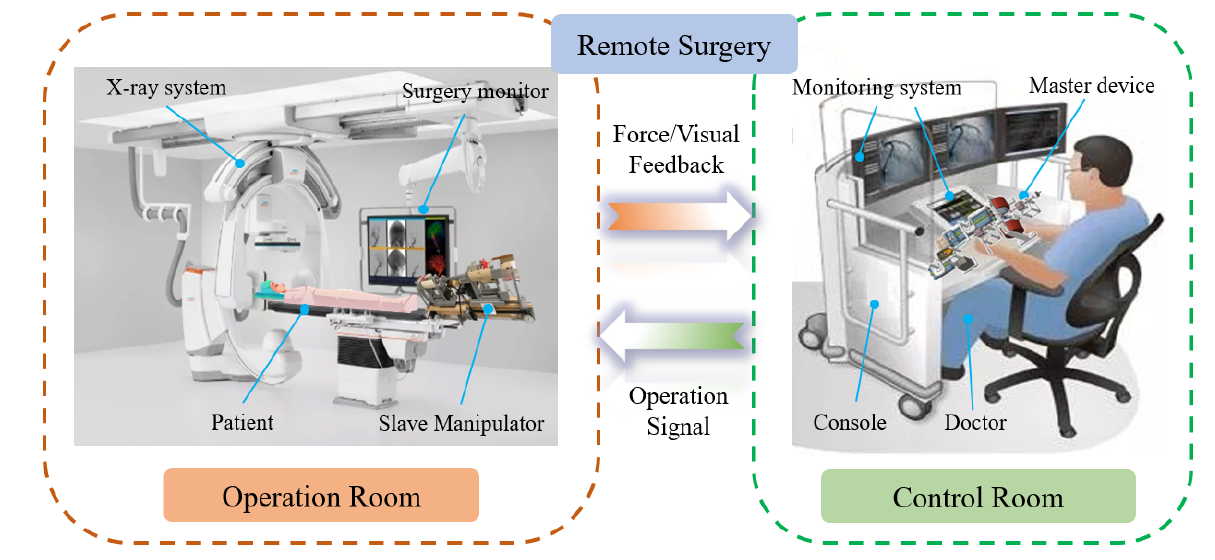
Figure 1. Schematic of the robot ‐ assisted endovascular catheterization remote surgery.